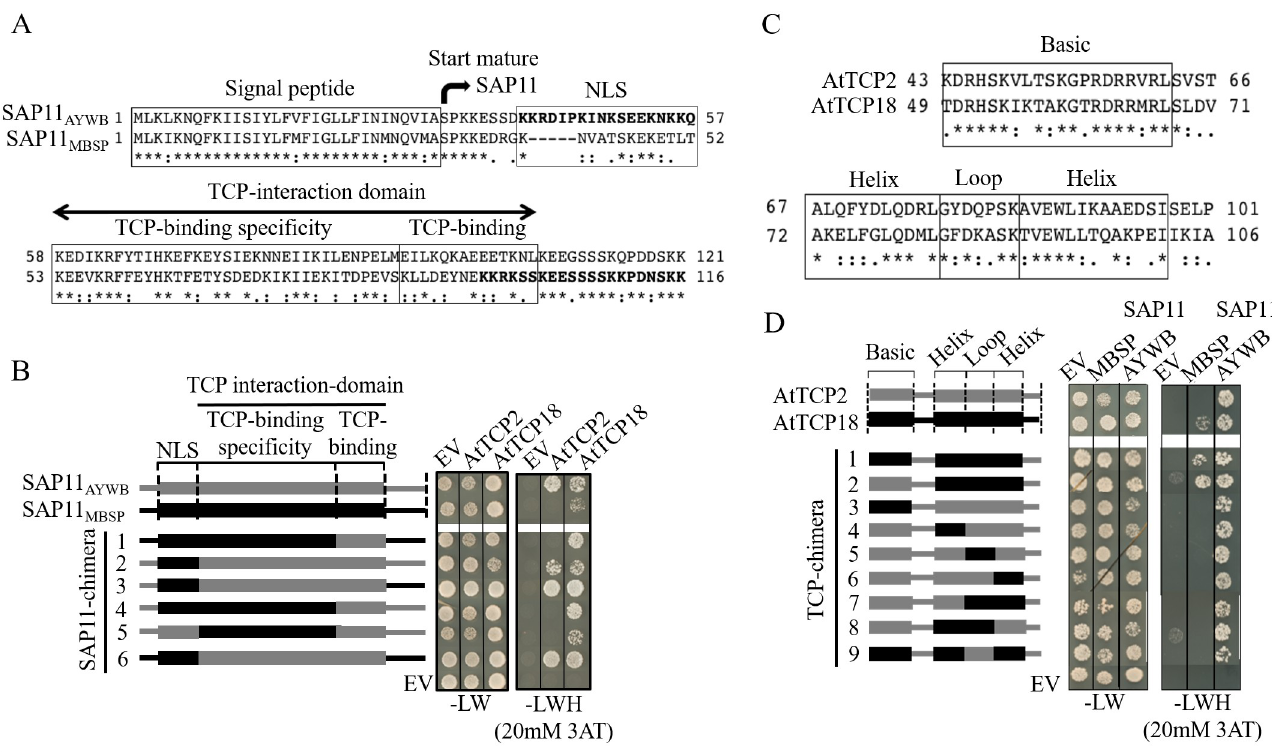
Fig 2. Characterization of domains involved in SAP11-TCP binding specificity. (A) SAP11 AYWB and SAP11 MBSP protein sequence alignment. Phytoplasmas secrete the mature protein, without signal peptide, into plants. The locations of the nuclear localization signal (NLS) in both proteins are indicated in bolt fonts. The regions corresponding to the SAP11 AYWB NLS that is not conserved in SAP11 MBSP within the rectangle are used for generating the chimeras in Fig 2B. The locations of regions within the TCP-interaction domains to generate the chimeras illustrated in Fig 2B are indicated with a double-sided arrow and within rectangles. (B) Yeast two-hybrid assays showing that the TCP-interaction domain determines binding specificity of SAP11 proteins to AtTCP2 (class II CIN-TCP) and BRC1 (AtTCP18) (BRC1, class II CYC/TB1 TCP). Domains identified in the SAP11 proteins and used for generating the chimeras correspond to those of Fig 2A. Abbreviations: EV, Empty vector control; -LW, media composition that enables yeast to grow when SAP11 and TCP plasmids are present; -LWH (20 mM 3-Amino-1,2,4-triazole (3AT)), selection medium that shows growth of yeast colonies when SAP11 and TCP interact. (C) Aligned amino acid sequences of the TCP domains of AtTCP2 and BRC1 (AtTCP18). Regions identified within the basic and helix-loop-helix domain are boxed and correspond to schematic illustrations of chimeras shown in Fig 2D. (D) Yeast two-hybrid assays showing that the binding specificity of SAP11 MBSP requires the complete BRC1 (AtTCP18) helix-loop-helix domain. Domains identified in the TCP proteins correspond to those of Fig 2C. Abbreviations: see legend for Fig 2B above.